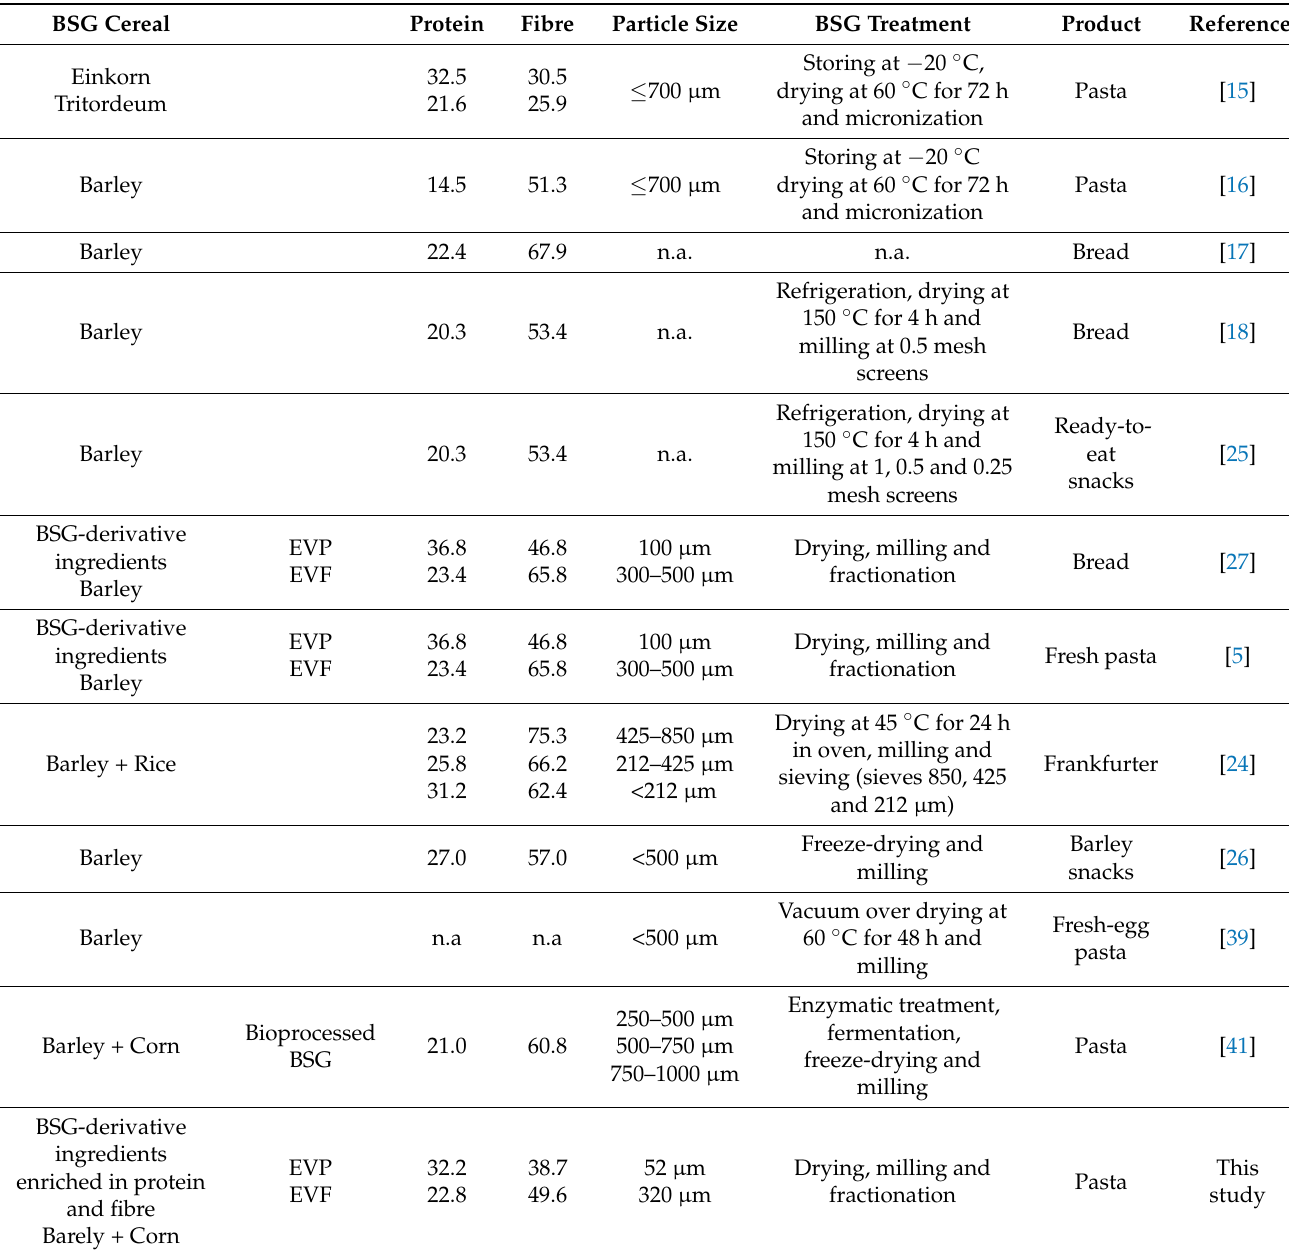
Table 3. Protein and fibre content (% d.w.), particle size and treatment and products realized using different